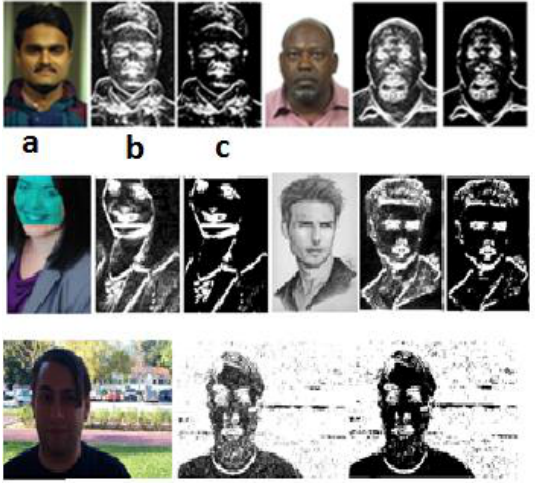
Figure 4. (a) The best Gabor filter bank output in the proposed method after setting the values of sigma and gamma parameters acurately. The values of other Gabor filter generation parameters are as follow: (b) The classical Gabor filter bank implementation.